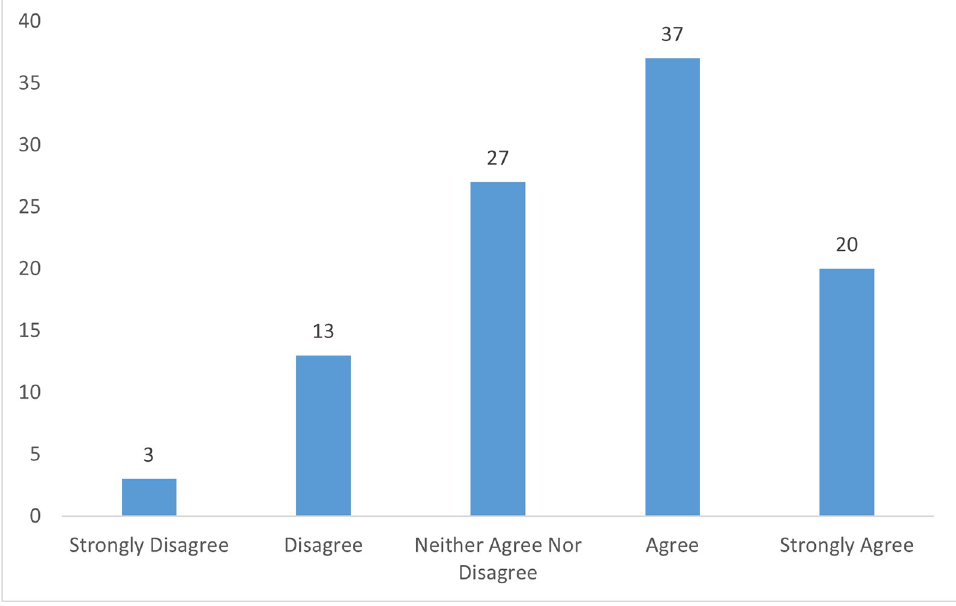
Fig 3. Ophthalmology doctors’ perceived competency facilitating work-focused discussions with patients as shown in percentages.